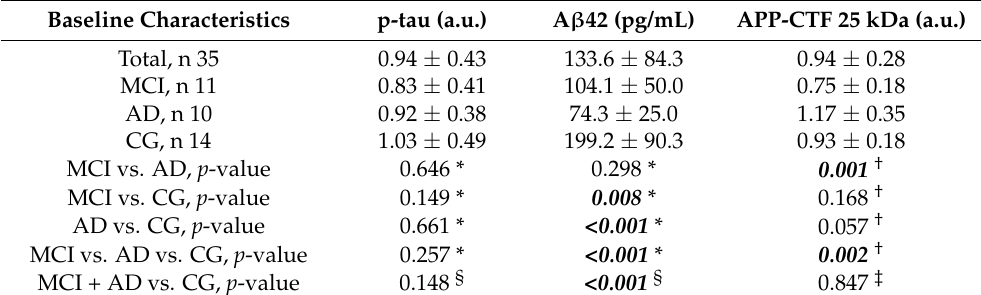
Table 5. Alzheimer’s biomarkers’ concentration in tear samples stratified by mild cognitive impairment due to Alzheimer’s disease (MCI), Alzheimer’s disease (AD) patients, and control group (CG).